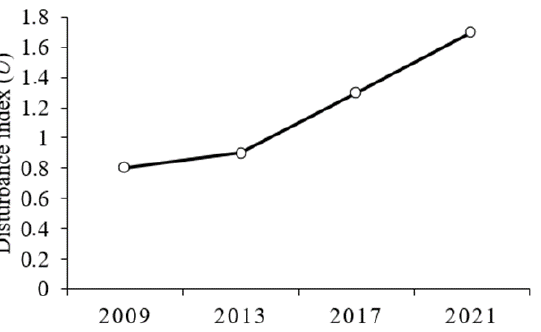
Figure 3. Evolution of the level of disturbance in the Kasomeno area in 2009, 2013, 2017 and 2021.